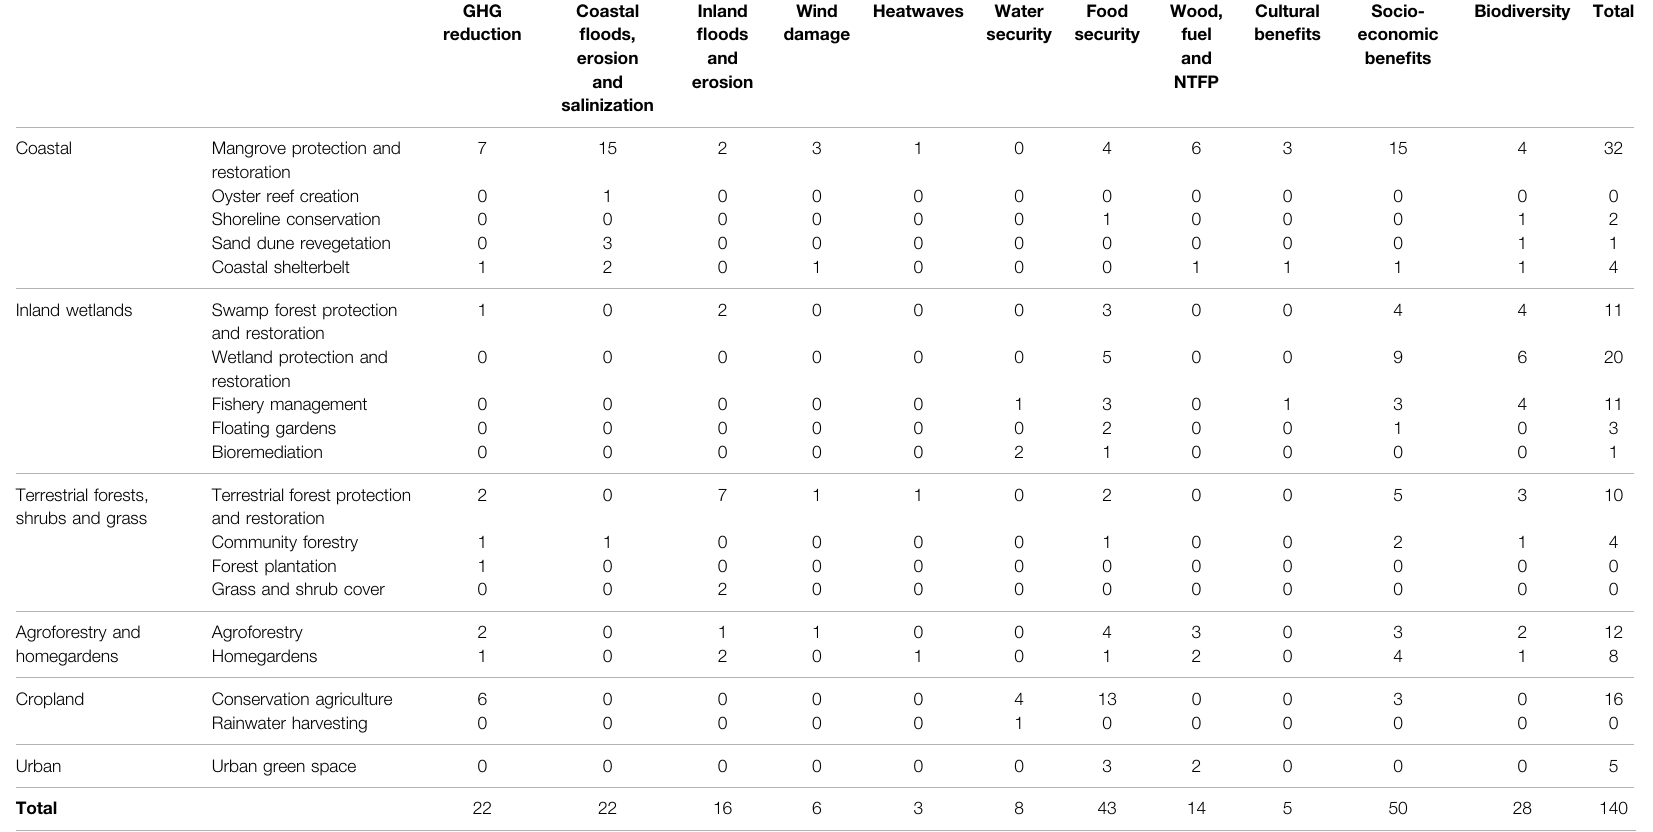
TABLE 4 | Number of positive outcomes reported in the literature reviewed for each type of